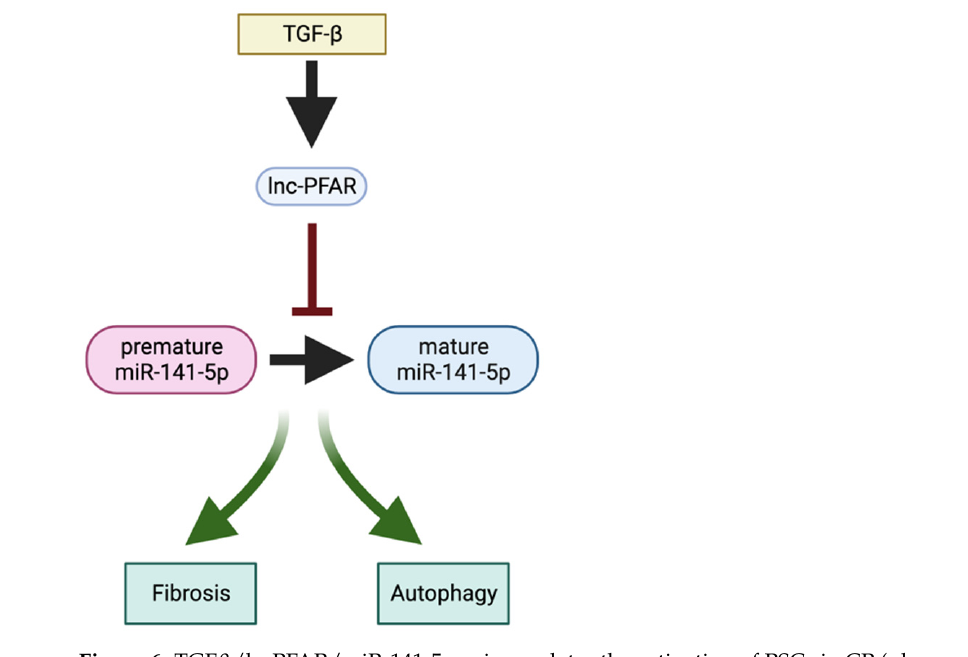
Figure 6. TGF β /ln-PFAR/miR-141-5p axis regulates the activation of PSCs in CP (please see text for details). Created with BioRender.com.